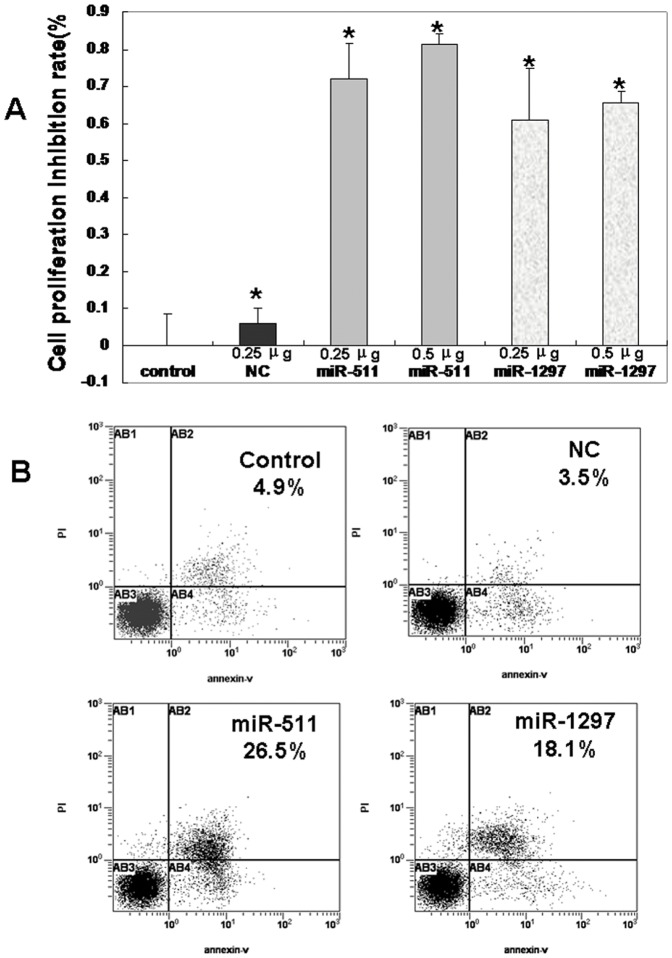
Detection of cell proliferation and apoptosis.(A) Proliferation inhibition rate of A549 cells analyzed by the MTT assay. The proliferation inhibition rates of A549 cells were >50% in the miR-511/1297-treated cultures compared with the NC-treated cultures (p<0.05), and the proliferation inhibition rates were dose-dependent, increasing with a higher concentration of miRNAs. (B) FACS analysis. Annexin V-FITC/PI staining was performed to evaluate the apoptosis of A549 cells. Apoptotic cells are shown in the upper left, upper right, and lower right quadrants of each panel. Apoptotic cells increased in the miR-511- and miR-1297-treated cells compared with the NC-treated cells.